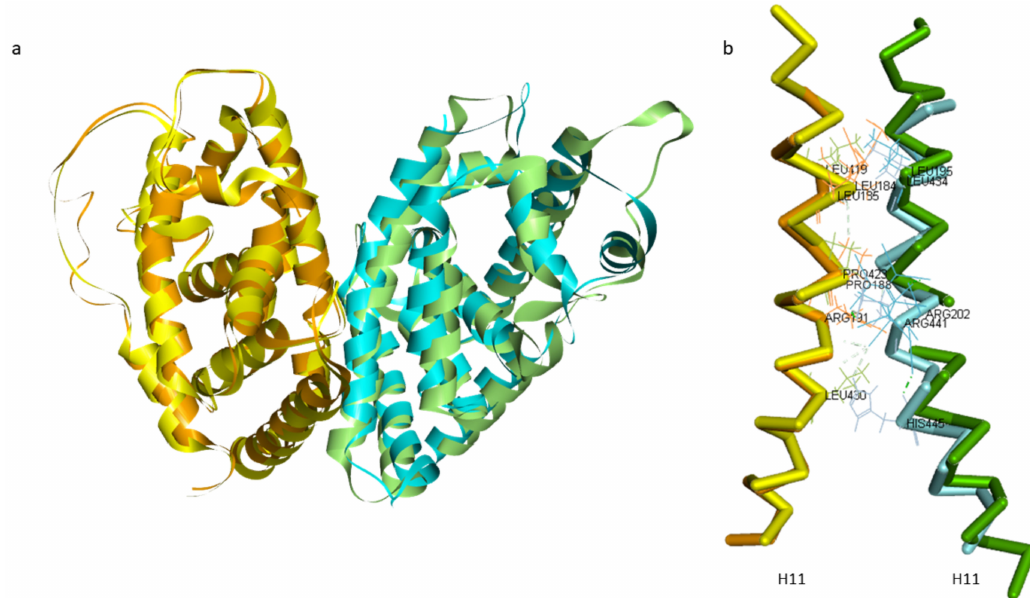
Figure 3. RXR α -FXR and USP-EcR dimers. ( a ) Alignment of the dimer of A. mellifera , USP (yellow) and EcR (green), and H. sapiens , RXR α (orange) and FXR (cyan). ( b ) Focus on the intermolecular interactions mediated by helices 11. Key residues that form the core hydrophobic interface of the parallel coiled are